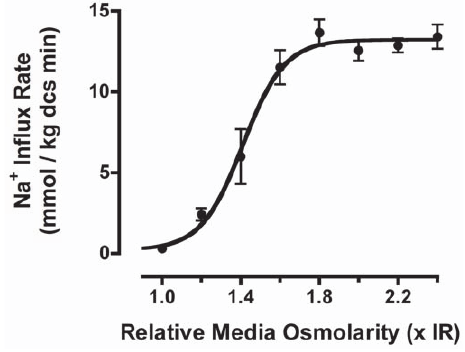
Figure 1. The stimulus-response relationship between medium osmolarity and NHE1 Na + transport activity in atRBCs. Unidirectional Na + influx rates ( 22 Na + initial rates) were measured in hyperosmotic media at a fixed media [Na + ]=100 mM, following complete activation of NHE1 by pre-incubation in thermodynamically nulled media of matched osmolarity. The data are fit to a sigmoidal curve by non-linear regression (Hill slope=4.1), yielding a maximal Na + influx rate of 13.2 mmoles Na + kg 2 1 dcs minute. (data are n $ 5 each; 6 SE).